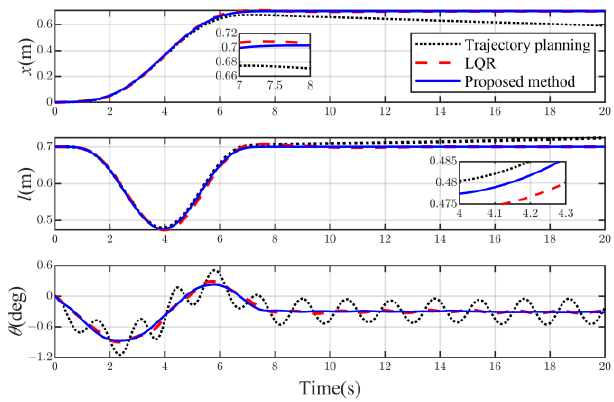
Figure 9. System state under external disturbances.